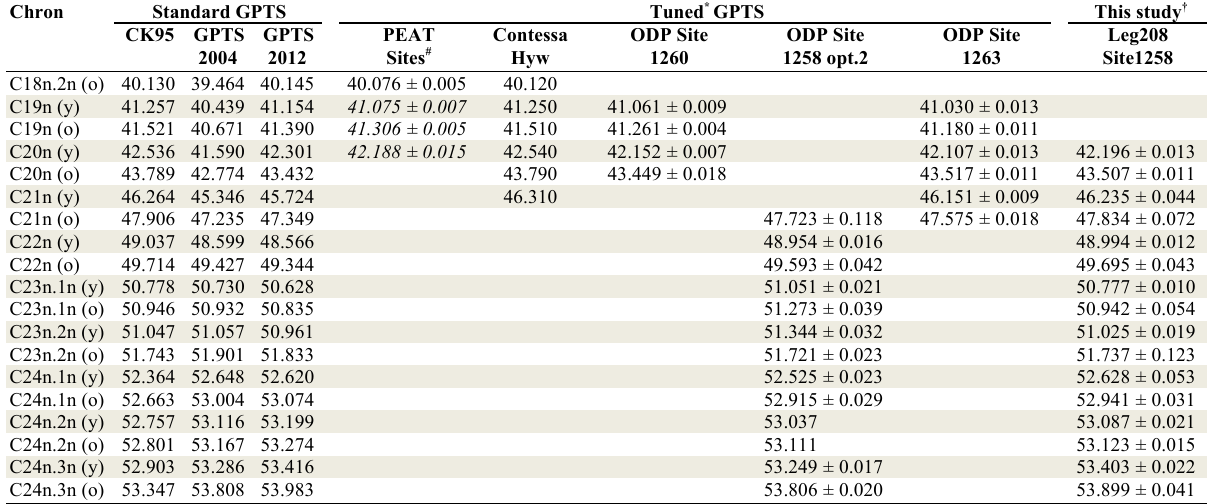
Table 1. Comparison of magnetochron boundary ages in millions of